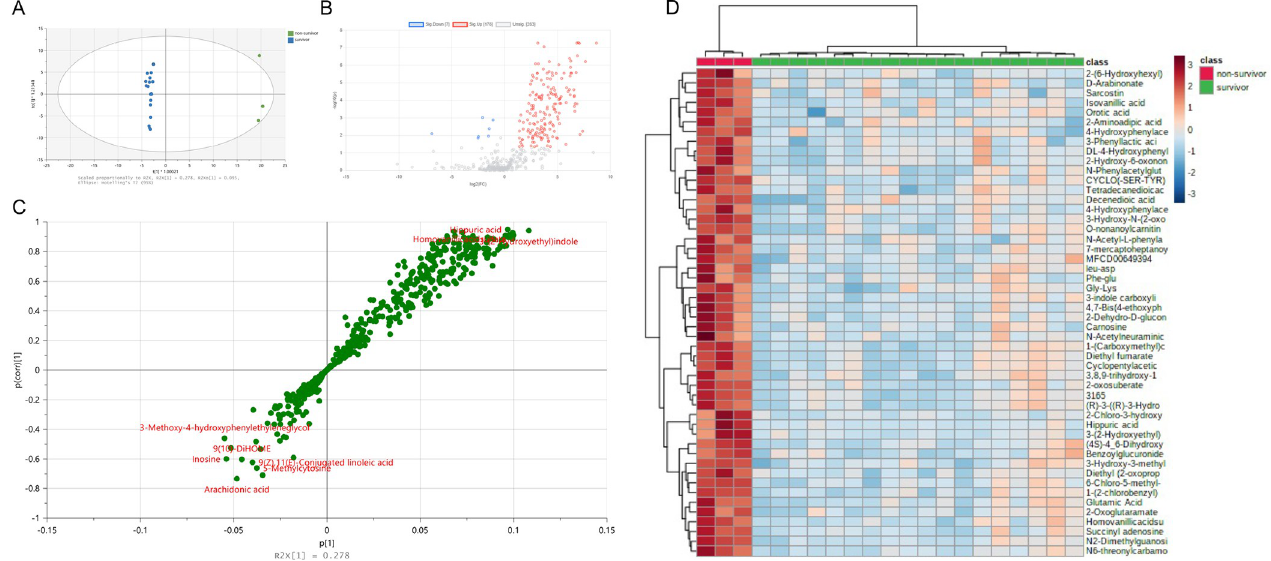
Fig 6. Identification of potential prognostic biomarkers for sepsis in dogs using untargeted metabolomics (C18 analyses). (A) OPLS-DA plot for C18 metabolites. R 2 X = 0.442, R 2 Y = 0.997, Q 2 = 0.859. (B) Volcano plots for C18 metabolites. Nonsurvivor / survivor. P-value < 0.05 FDR, log 2 (fold change) > 2.0. (C) S-plot of metabolites identified by C18 analysis and their modeled class designation. (D) Heatmap: Top 50 significant metabolites in C18 after log transformation and pareto scaling.